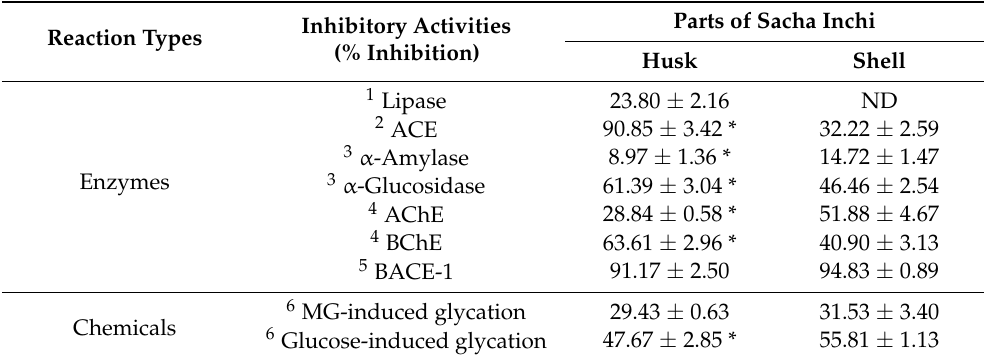
Table 6. Inhibitory activities of enzymatic and non-enzymatic (chemical) reactions in the husk and shell of sacha